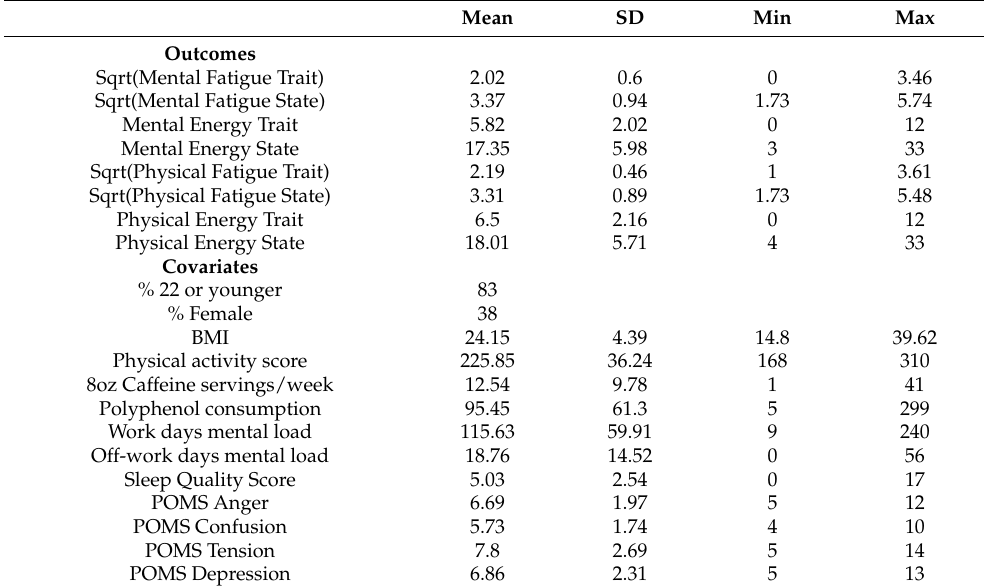
Table 1. Descriptive statistics for continuous variables (N =